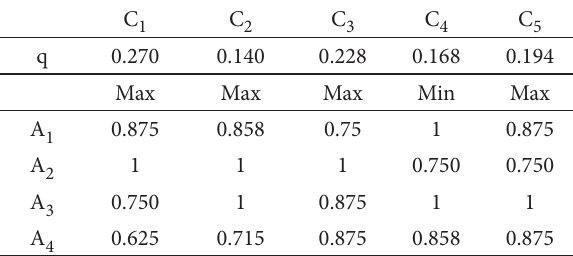
Table 5. WASPAS normalized decision making matrix